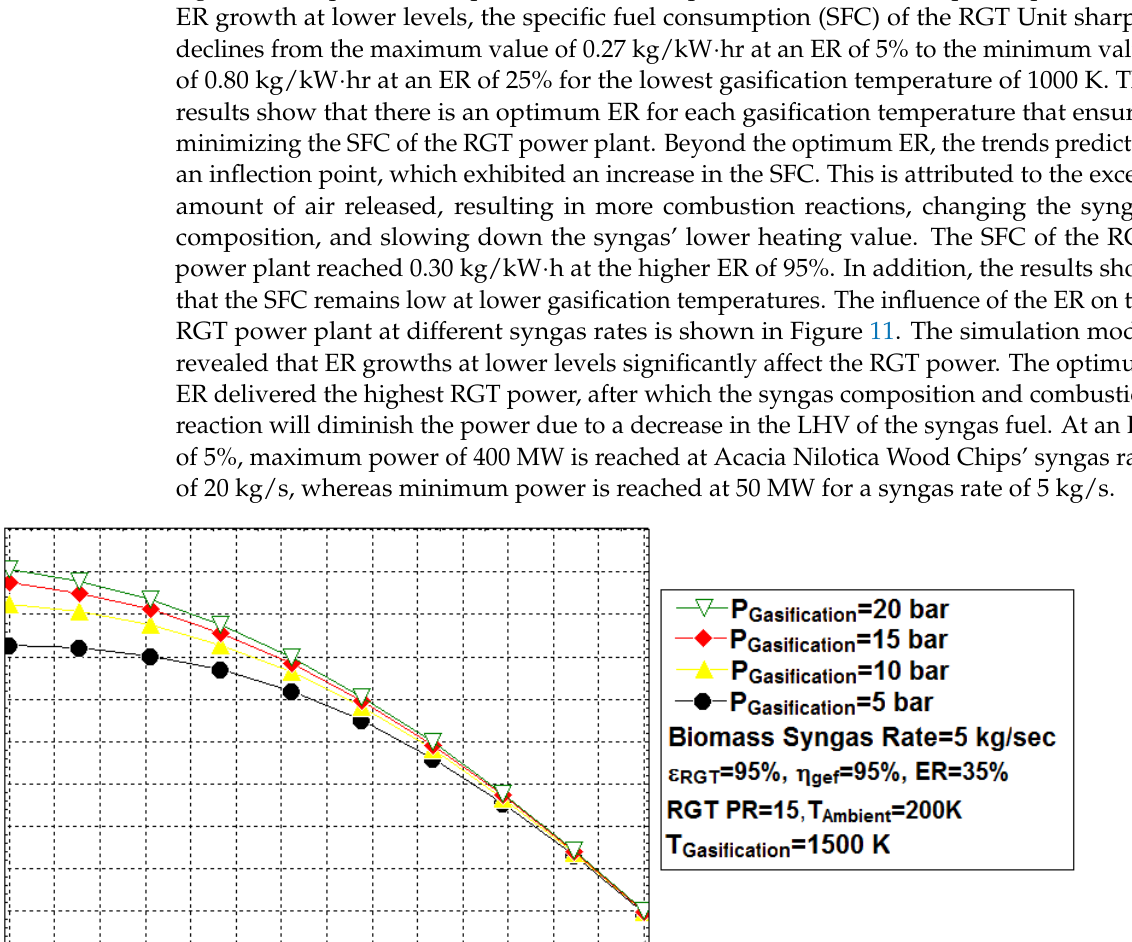
Figure 9. Variation of gasifier efficiency with biomass flow rate at different Wood Chip syngas rates. As plotted in Figure 10, at different gasification temperatures (1000–1600 K), pressure of 20 bar, biomass moisture content of 12%, and syngas rate of 5 kg/s, the ER shows a significant impact on the specific fuel consumption (SFC) of the RGT power plant. With ER growth at lower levels, the specific fuel consumption (SFC) of the RGT Unit sharply declines from the maximum value of 0.27 kg/kW·hr at an ER of 5% to the minimum value of 0.80 kg/kW·hr at an ER of 25% for the lowest gasification temperature of 1000 K. The results show that there is an optimum ER for each gasification temperature that ensures minimizing the SFC of the RGT power plant. Beyond the optimum ER, the trends pre- dicted an inflection point, which exhibited an increase in the SFC. This is attributed to the excess amount of air released, resulting in more combustion reactions, changing the syn- gas composition, and slowing down the syngas’ lower heating value. The SFC of the RGT power plant reached 0.30 kg/kW·h at the higher ER of 95%. In addition, the results show